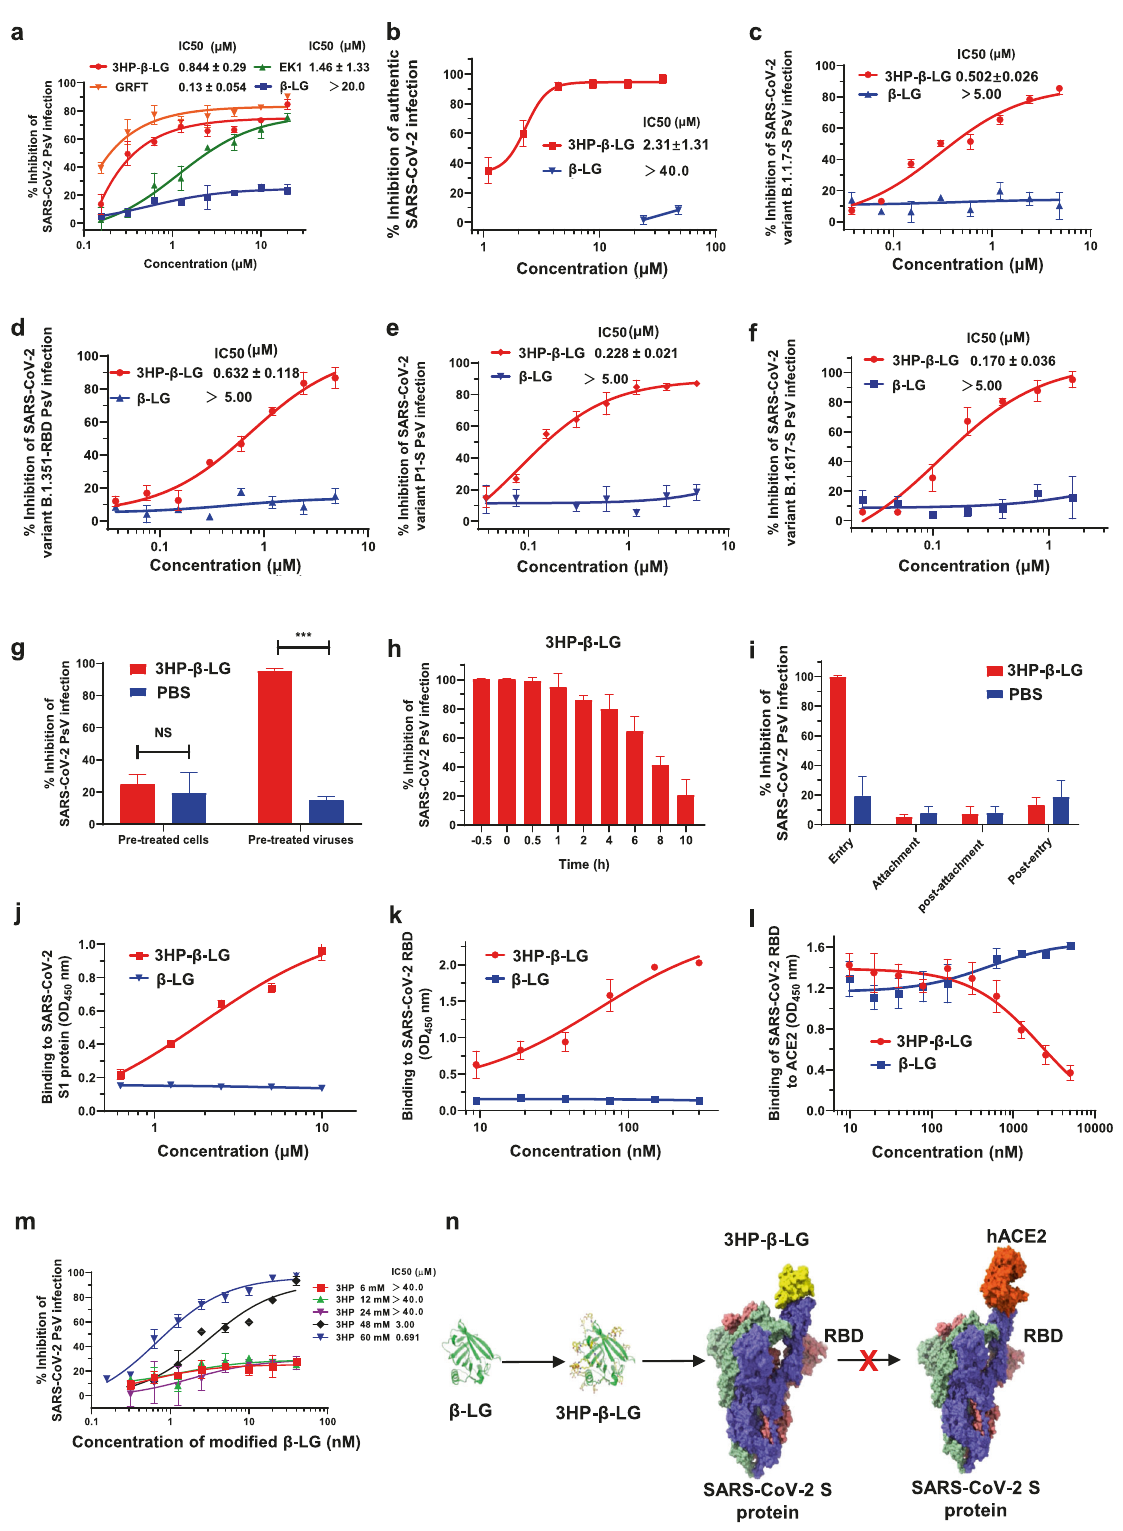
Given that 3HP- β -LG-containing anti-HPV biological dressing has been safely used via intravaginal application to block HPV infection for more than 7 years, 3 3HP- β -LG is expected to be safe via intranasal application for prevention and treatment of SARS- CoV-2 infection. Since β -LG is the major component of